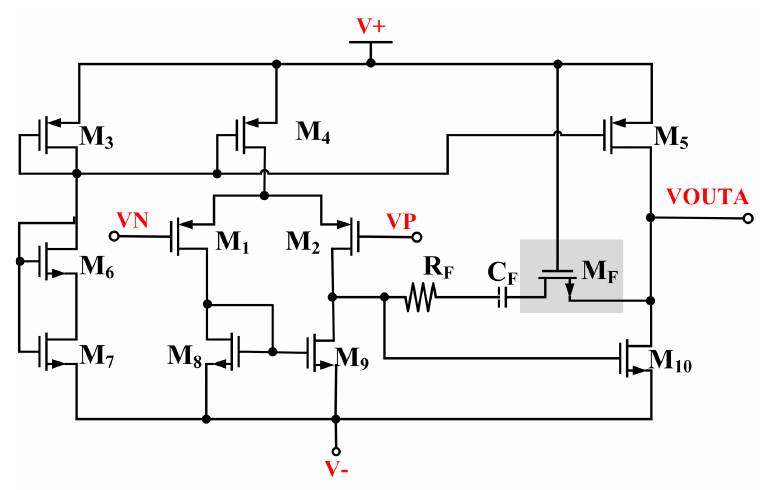
Figure 8. Schematic of the high gain error